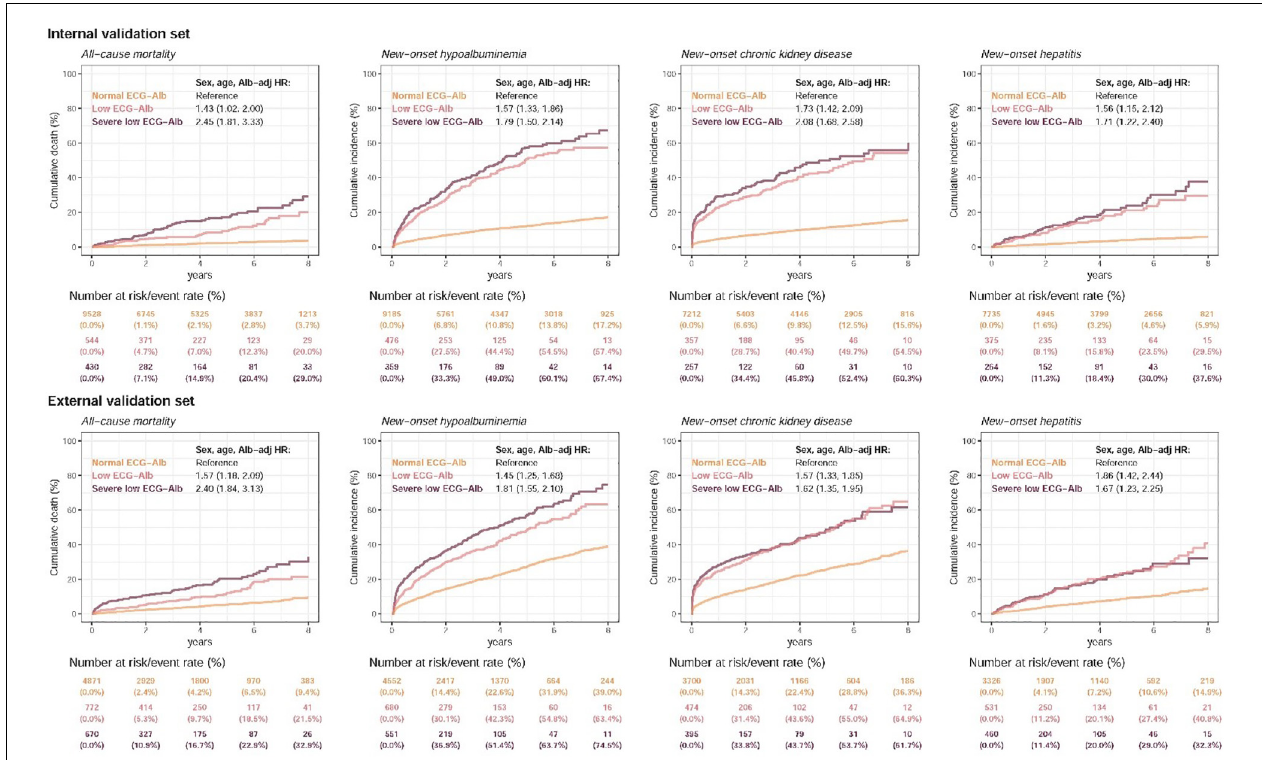
FIGURE 5 | Long-term incidence of developing new-onset malnutrition events in patients with an initially normal albumin (Alb) of > 3.5 g/dL stratified by AI-ECG prediction. The AI-ECG predictions were classified as normal ECG-Alb (yellow line), low ECG-Alb (pink line), and severe low ECG-Alb (burgundy line) based on the operating points, as in the previous ROC curve analysis. The analyses were conducted both in the internal and external validation sets. The table shows the at-risk population and cumulative risk for the given time intervals in each risk